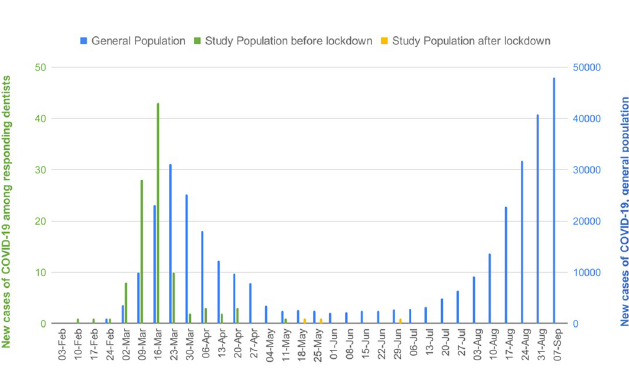
Fig 1. Weekly evolution of new cases of Covid-19 in